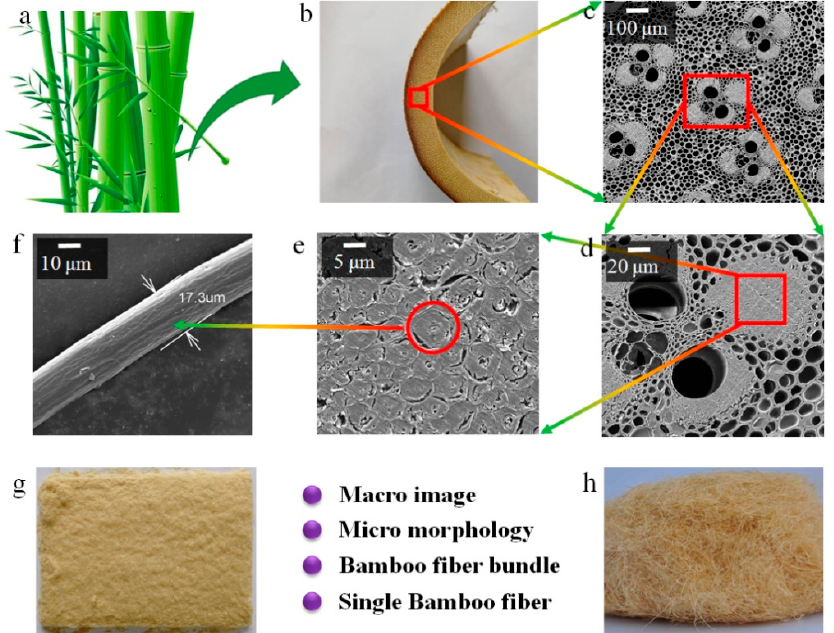
Figure 1. Macro images and micro morphology of bamboo: ( a ) bamboo, ( b ) cross section of cylindrical bamboo culm, ( c – f ) distribution of bamboo fiber in bamboo culm, ( g,h ) macro images of the single bamboo fibers (SBFs) and bamboo fiber bundle.